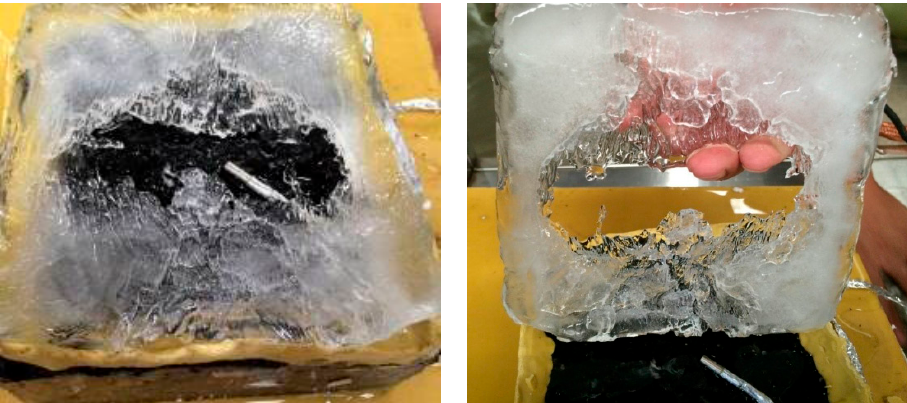
Figure 8. Ice after microwave irradiation.